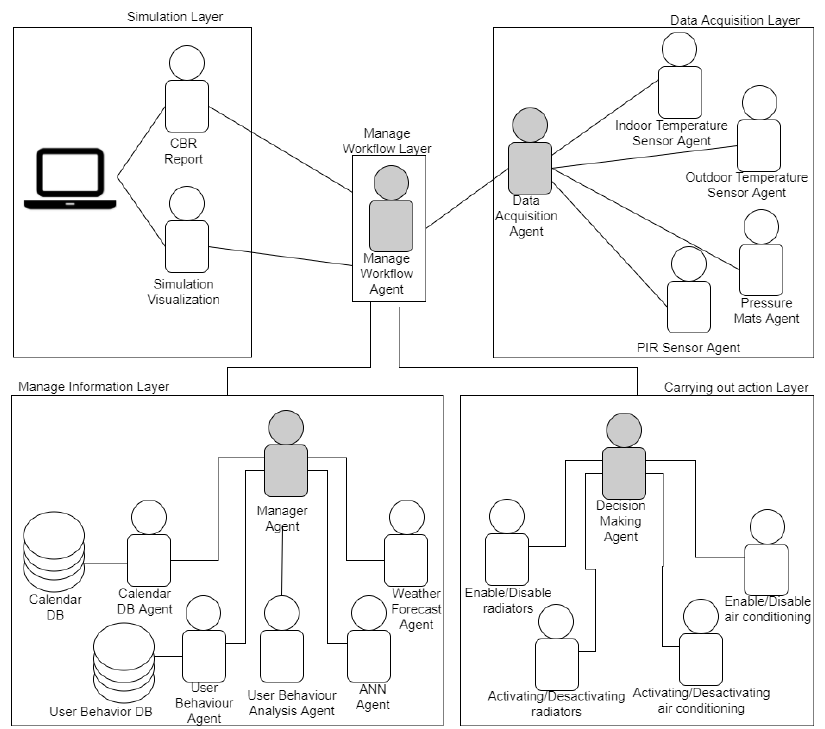
Figure 1. Multi-agent system arquitecture.